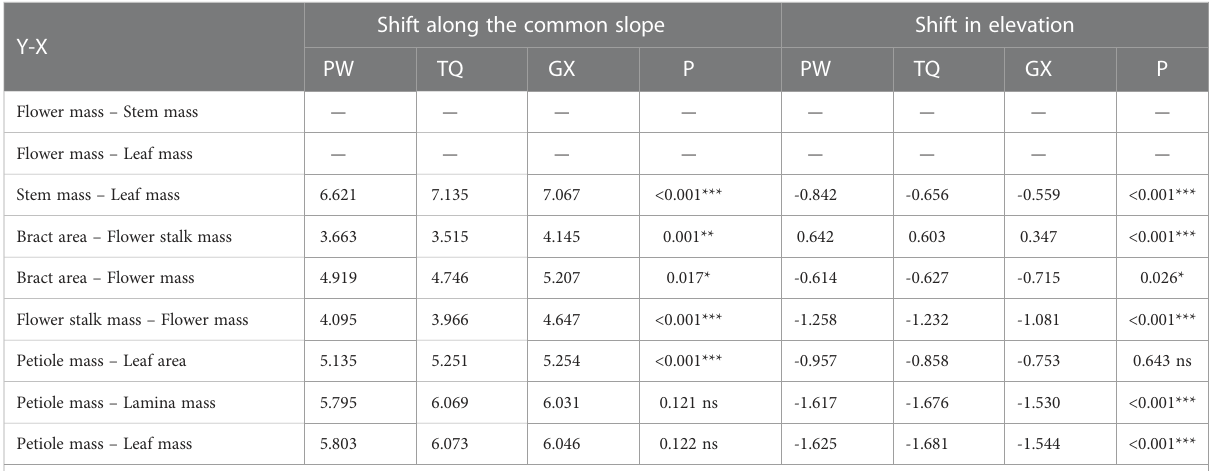
TABLE 5 Tests for heterogeneity of slope, and shift in intercept for the relationships among functional traits of annual D . involucrata twig in three latitude regions. Shift along the common slope Shift in Y-X